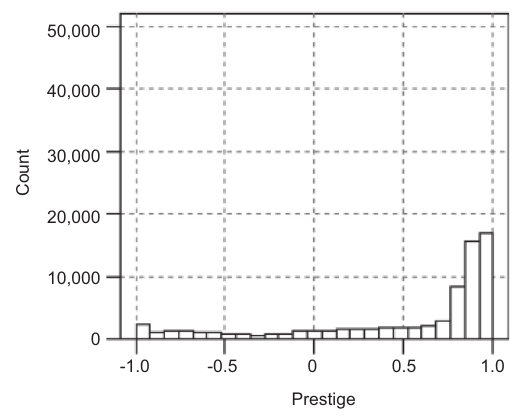
Figure 3. Distribution of Prestige for